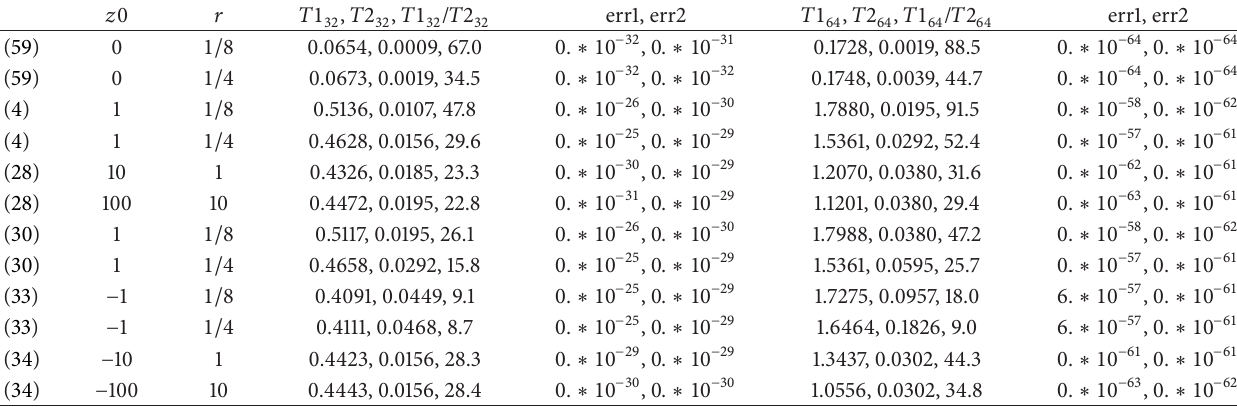
Table 1: Time-consuming comparison of the algorithms (59), (4), (28), (30), (33), and (34) with PolyLog for different precistions ( 𝑛 = 4 , 𝑝 = 5 , and 𝑚 = 16 ).